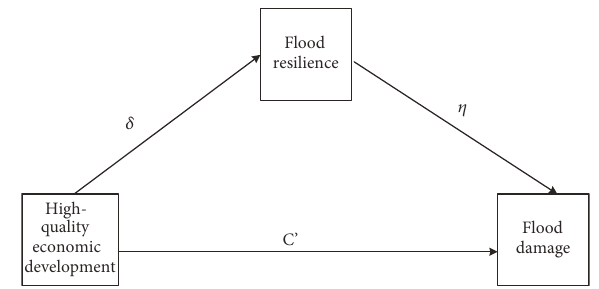
Figure 3: The mediating effect of FR (C ′ represents the direct effect of HQED on FD; the product of δ and η represents the indirect effect of HQED transmitted to FD through